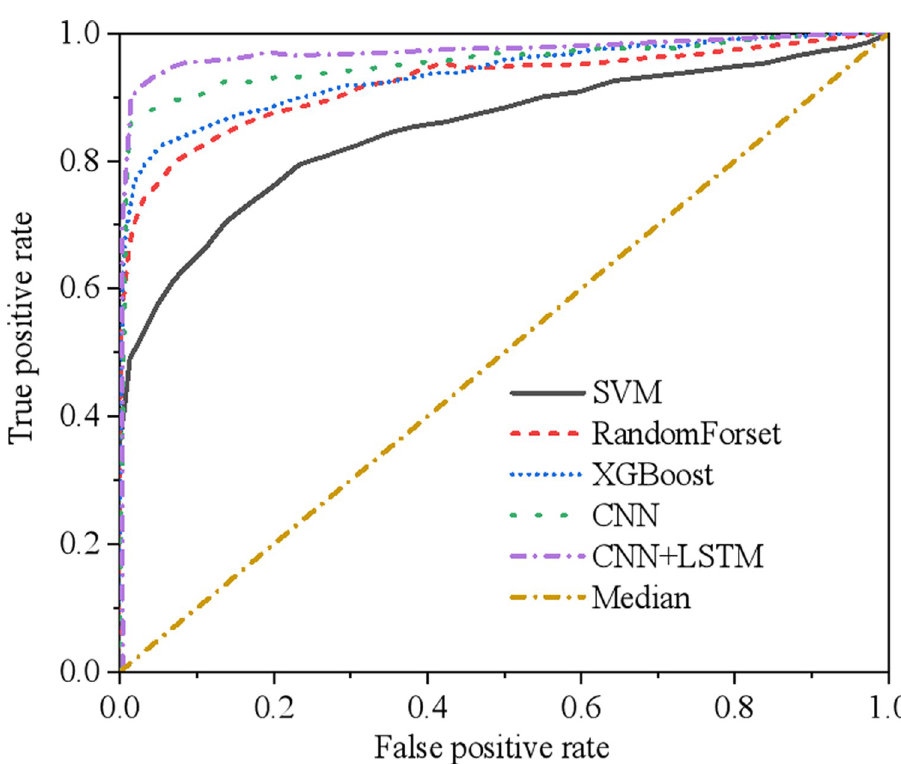
Fig 15. ROC curves of CNN + LSTM model and traditional